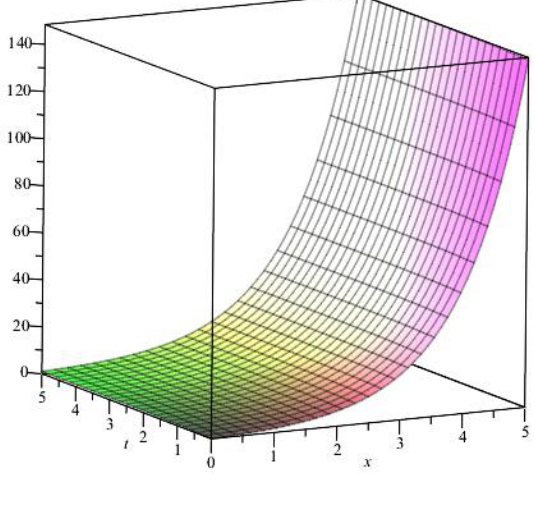
Figure 1. The values of the options for α = 0.8 and ρ = 1 are depicted by ( ?? ) demonstrated in Figure 2. 243